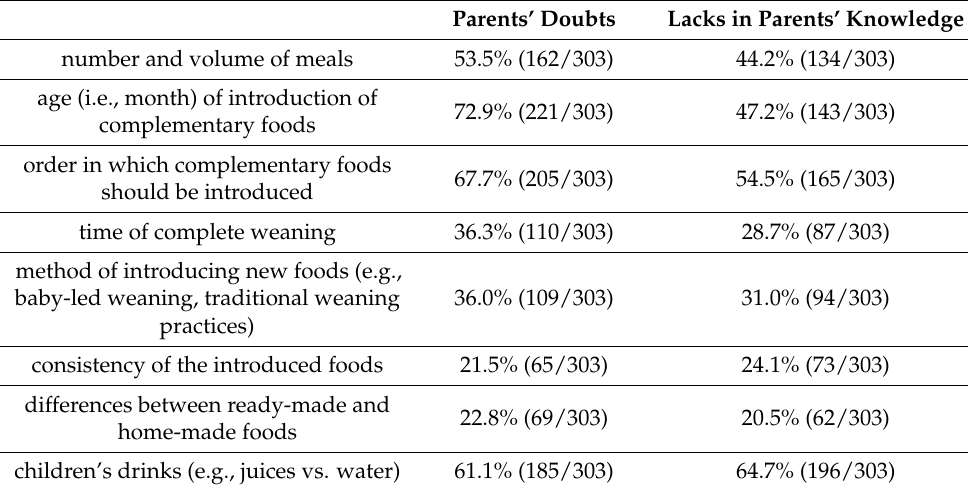
Table 1. Questions parents ask their doctors and the lacks in parental knowledge as assessed by